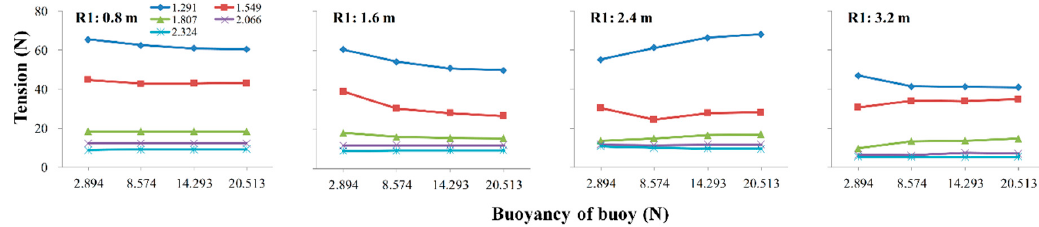
Figure 11. Maximum mooring tension according to wave period, bridle-line length (R1), and buoyancy of the damping buoy (B) at a wave height of 0.333 m.